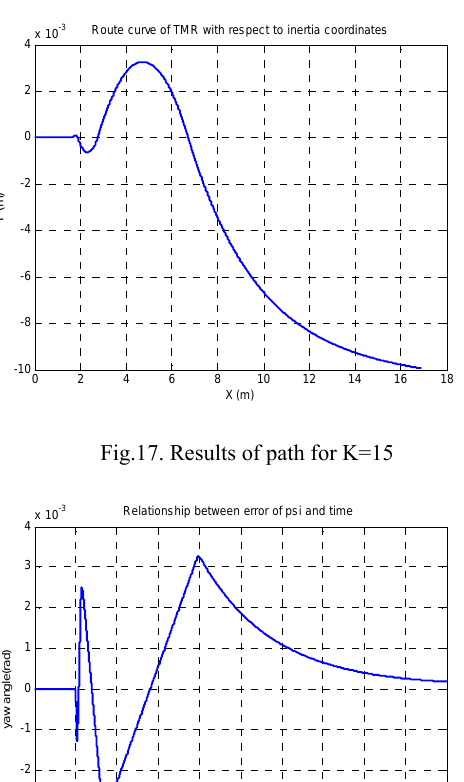
Fig.16. Results of error of ψ for K=10